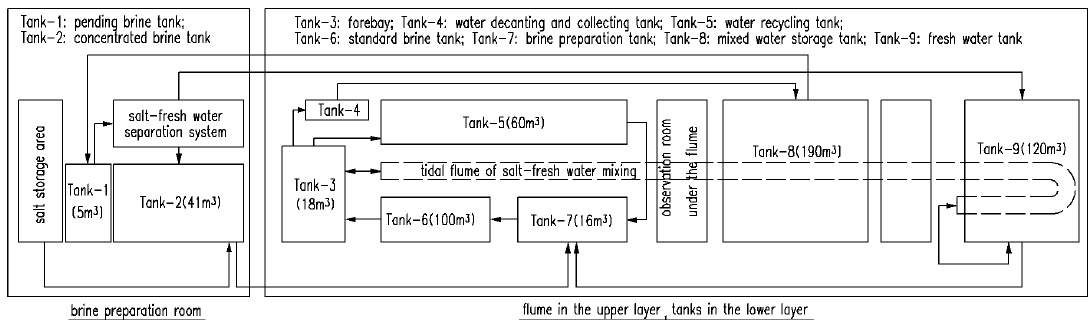
Figure 1. Diagram of flume layout and test water transmission. The number in the brackets represents the capacity of tank. The arrow represents the transmission direction of test water.